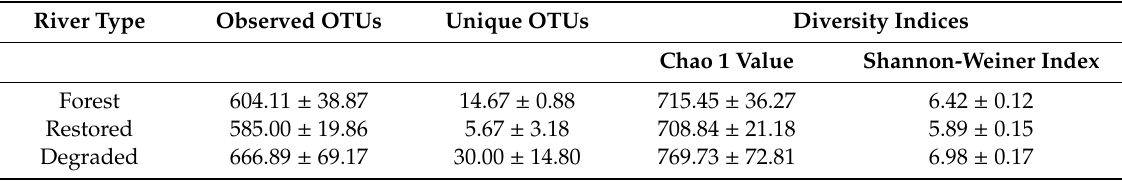
Table 2. Mean values of microbial diversity in di ff erent types of rivers within the Anji City Region, PRC. The values represent the mean ± standard error of three replicate